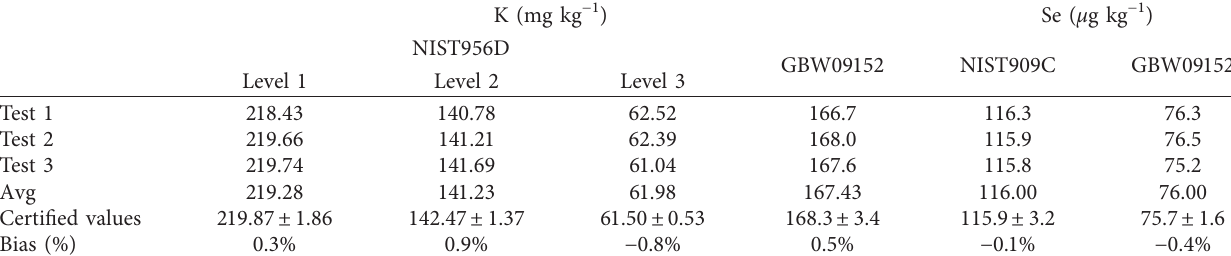
Table 3: Analysis of standard reference material by two-way ID-ICPMS.